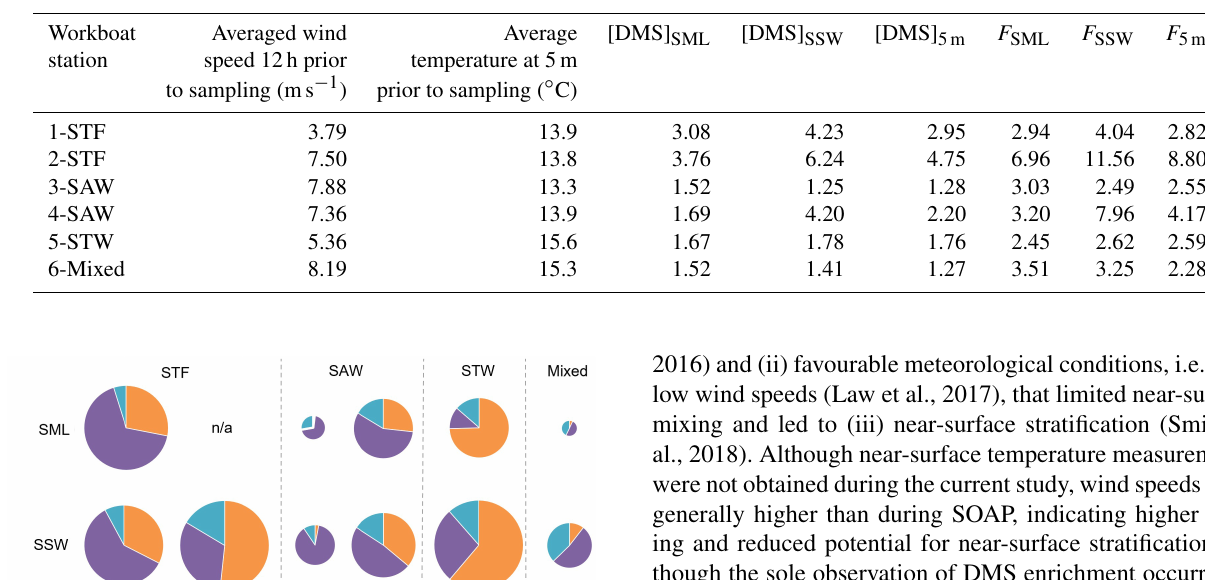
Table 4. DMS air–sea flux calculated using the COARE algorithm for each station. SML DMS concentration was obtained with the gas- permeable tube. DMS concentrations are in nmolL − 1 , and the flux is expressed in µmolm − 2 d − 1 .